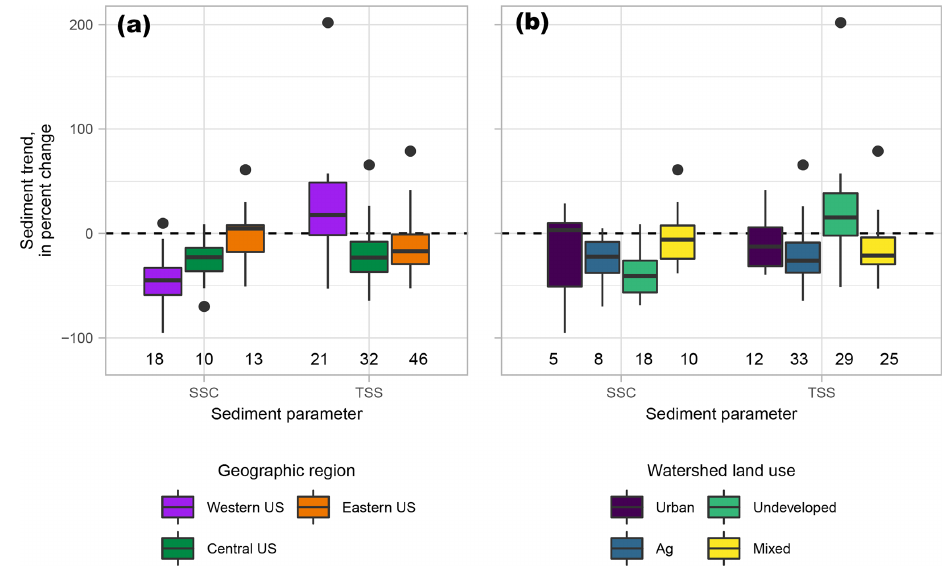
Figure 2. SSC and TSS trends by (a) geographic regions (depicted in Fig. 1) and (b) land use of watershed, including all sites and likelihoods. Dashed line denotes 0% change. Numbers above x axis are site counts. For the boxplots, the top and bottom of the boxes correspond to the interquartile range (25th and 75th percentiles); top and bottom whiskers correspond to 1.5 × (interquartile range); and points are data falling beyond 1.5 × (interquartile range).